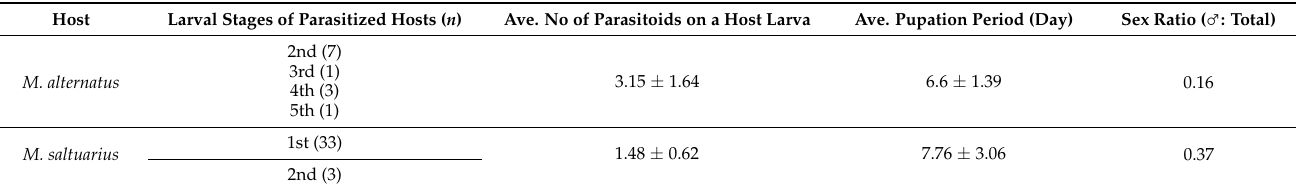
Table 1. Biological information of Spathius verustus by host.